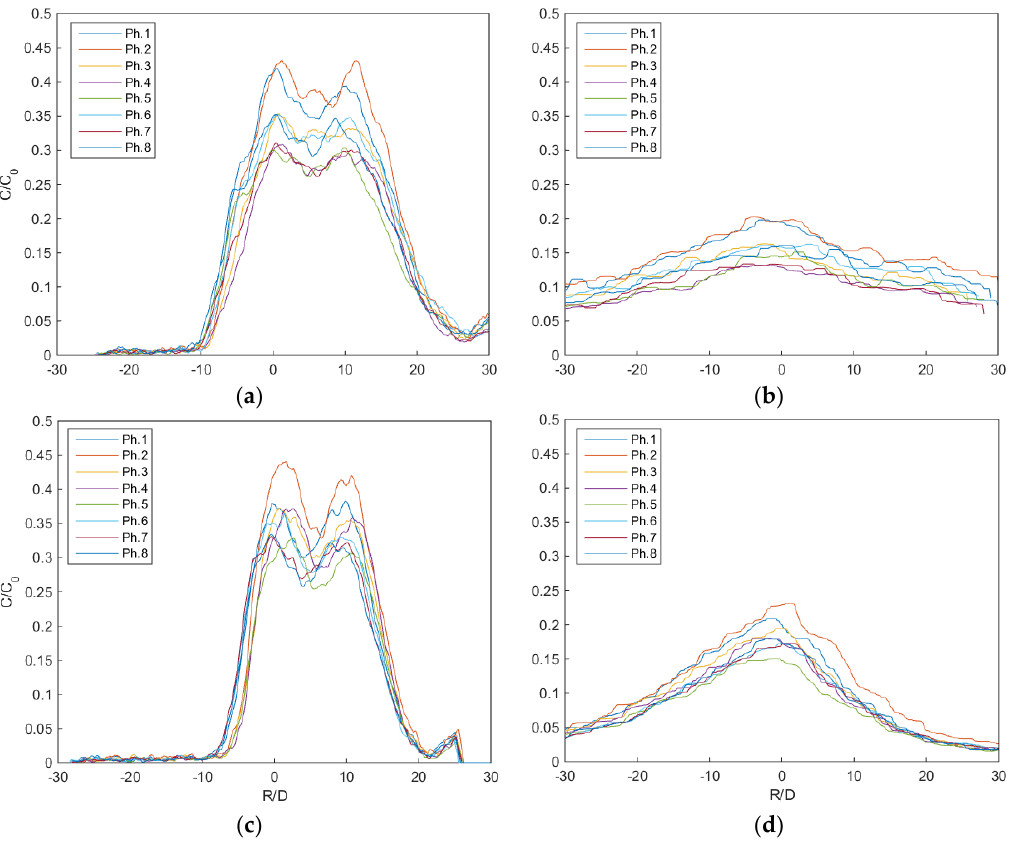
Figure 9. Cross-sectional non-dimensional mean concentration profiles for a NBJ with Fr = 28.0 ( a , b ) and for a NBJ with Fr = 18.0 ( c , d ) released in a receiving body affected by regular waves with T = 1.00 s and A = 12.5 mm; (a,c) vertical profiles on the point of maximum height; (b,d) horizontal profiles on the impact point; R/D is the non-dimensional span-wise abscissa.